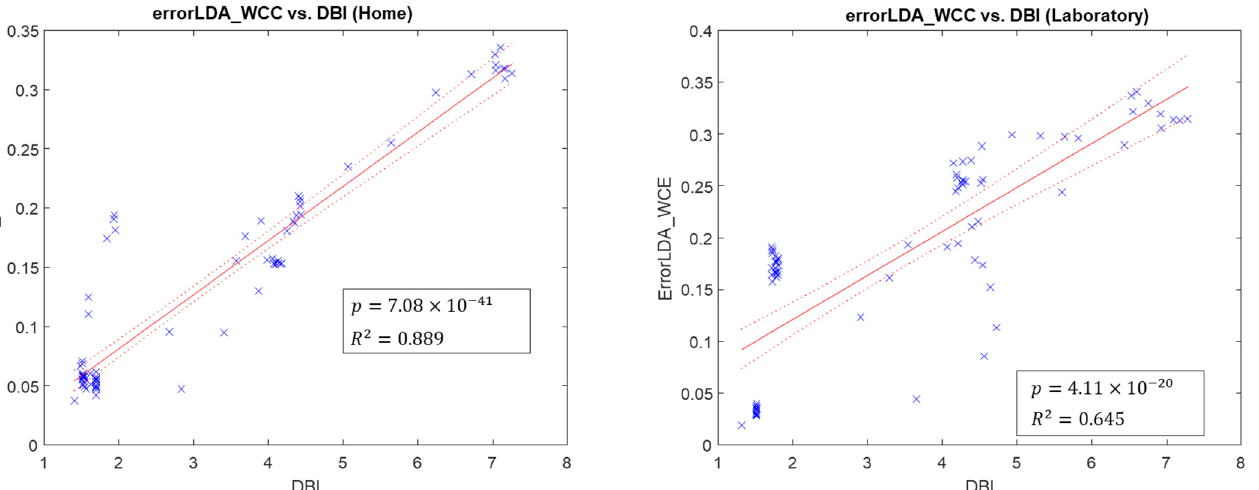
Figure 4. Scatter plots of linear regression fitted models (in red), where BCC error is related to RI. Each blue x represents a sample result.